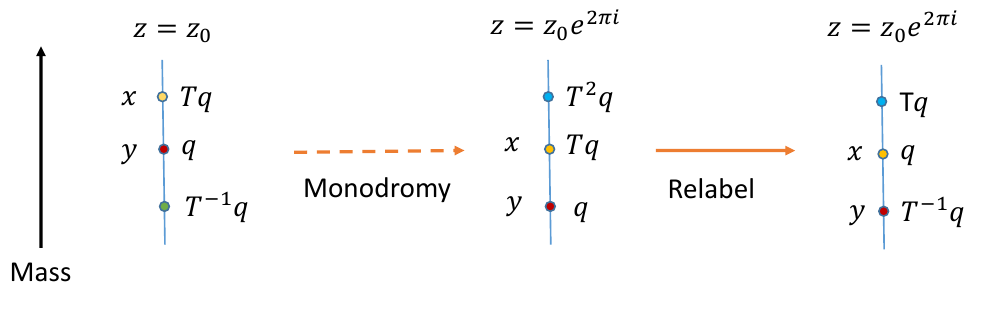
Figure 2 . Figure showing the states in the theory at z = z 0 and z = z 0 e 2 (cid:25)i . The labels x and y track each physical state. The state y of charge q is BPS at z = z 0 and the state x of charge T q is BPS at z = z 0 e 2 (cid:25)i . In the last step the charges of all the states are simultaneously relabelled so that the spectrum matches the one before the